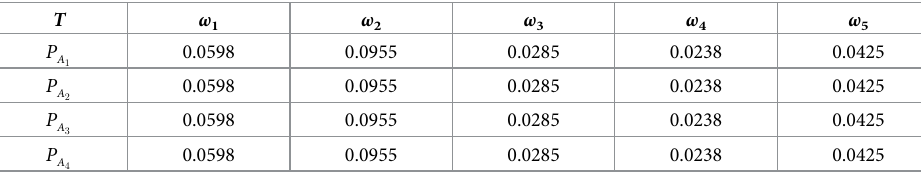
Table 4. Theoretical assessment matrix T .